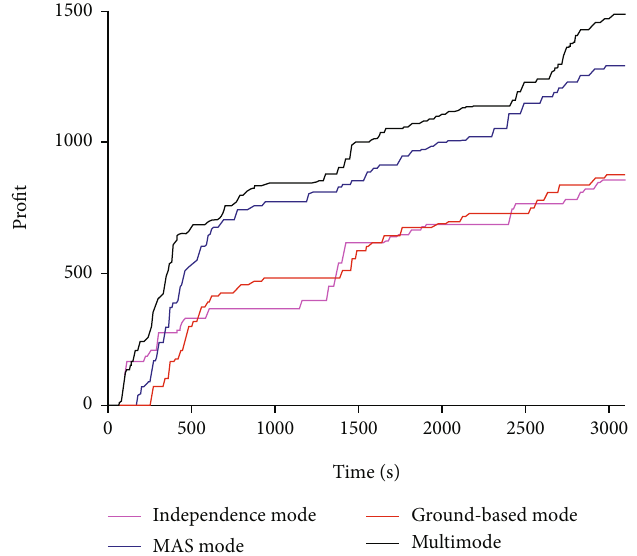
Figure 9: The pro fi ts of all